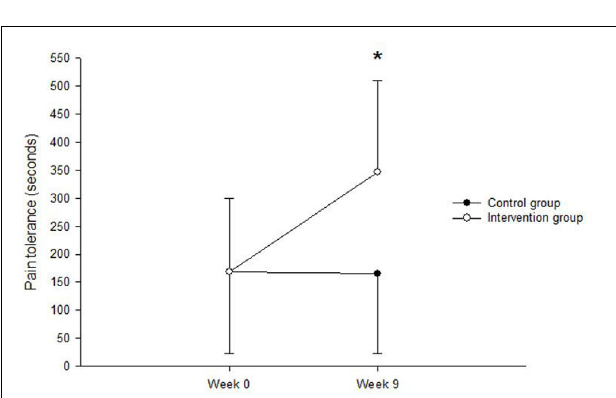
FIGURE 2 | Showing the Time × Group interaction for pain